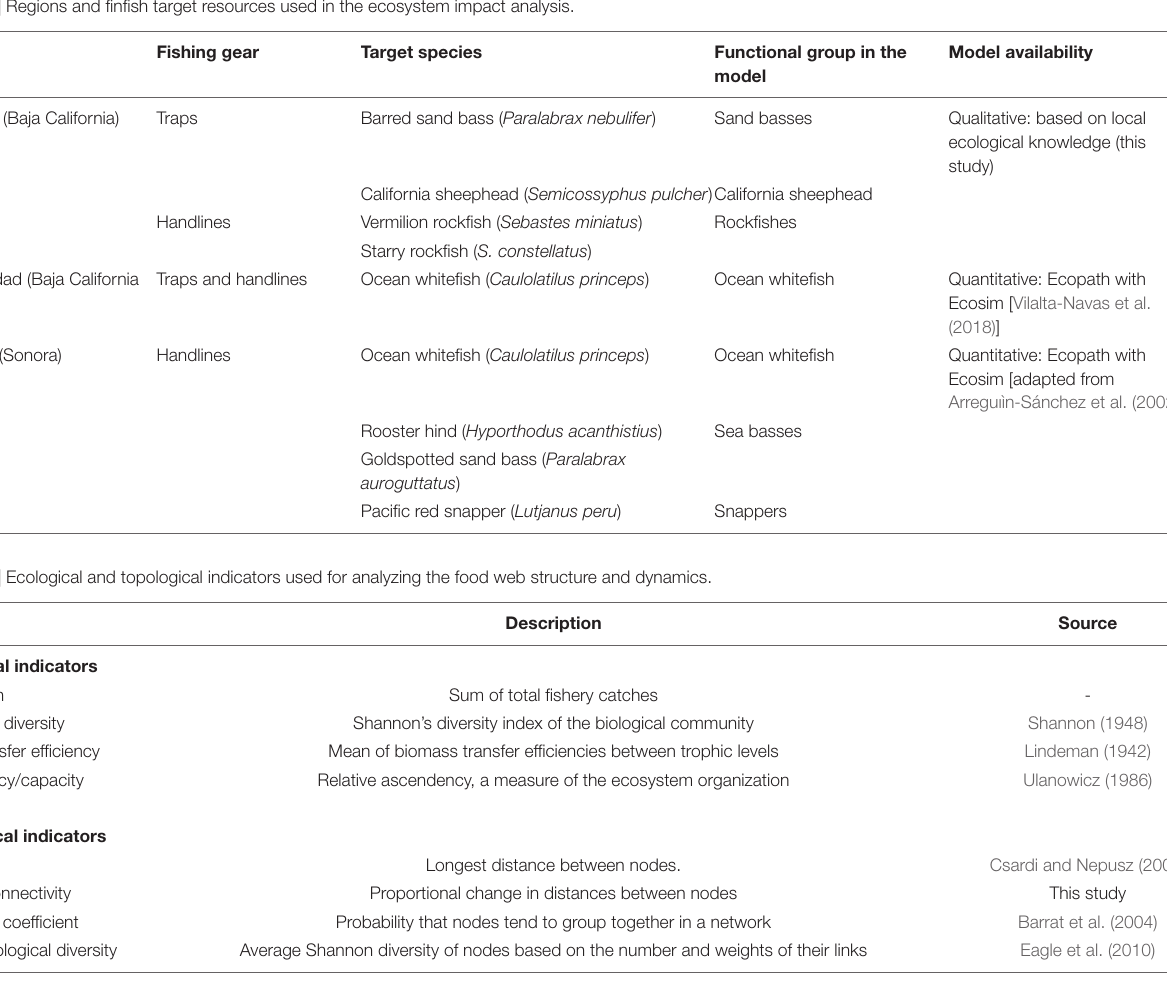
TABLE 1 | Regions and finfish target resources used in the ecosystem impact analysis.